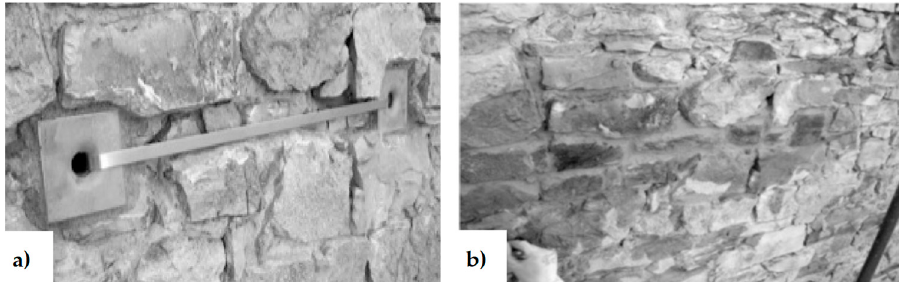
Figure 10. How to hide the CAM ribbons to meet the aesthetic requirements: a ) arrangement in slit of a steel ribbon and its protective steel plates; b ) restoring of the cover stone material. Figure 9. An example of reinforcement with the CAM system: 2:3 ‐ scale model for testing on a shaking table [48]: a ) internal view; b ) external view.